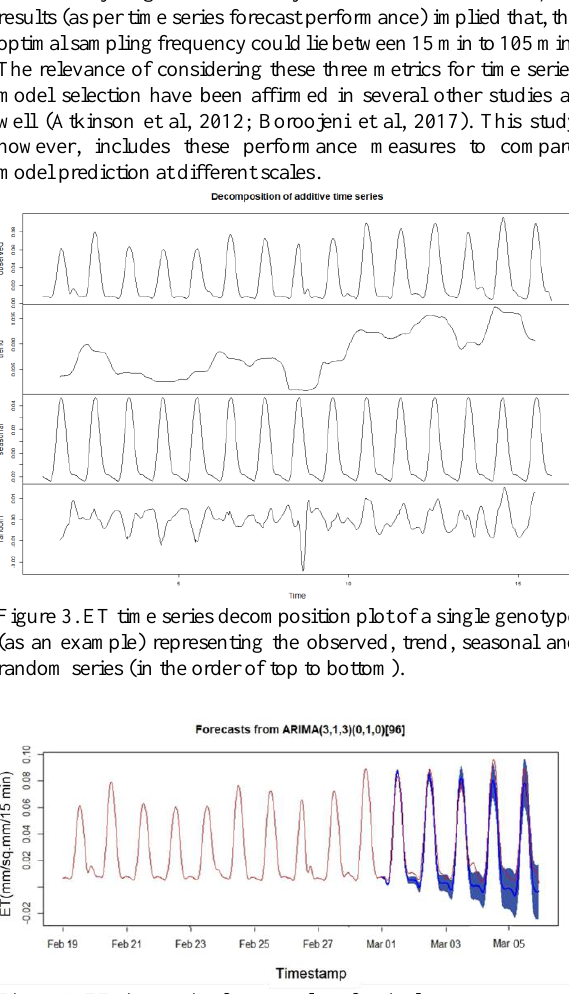
Figure 4. ET time series forecast plot of a single genotype as per the best fit ARIMA model